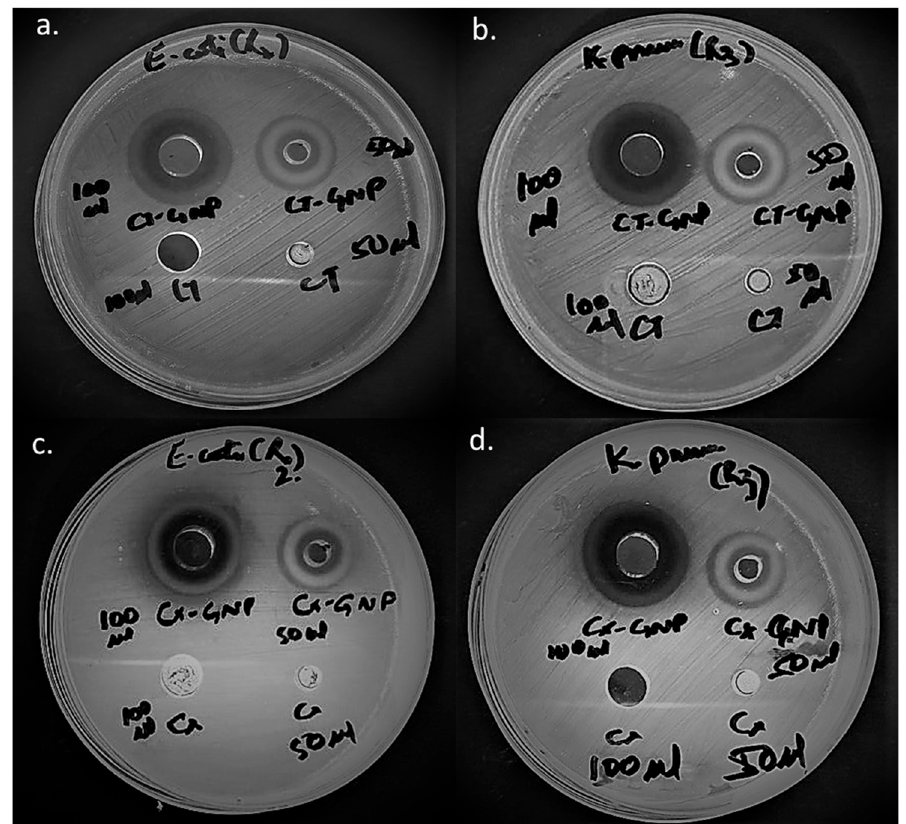
Figure 6. Antibacterial activity of ( a ) pure CT and CT-AuNPs against E.coli , ( b ) pure CT and CT-AuNPs against K.pneumoniae , ( c ) pure CX and CX-AuNPs against E.coli , and ( d ) pure CX and CX-AuNPs against K.pneumoniae. Table 1: Inhibition zones of CT-AuNPs and CX-AuNPs against E. coli and K. pneumoniae.